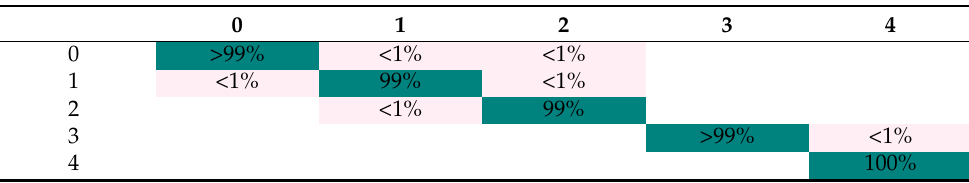
Table 8. A confusion matrix for the SVM model